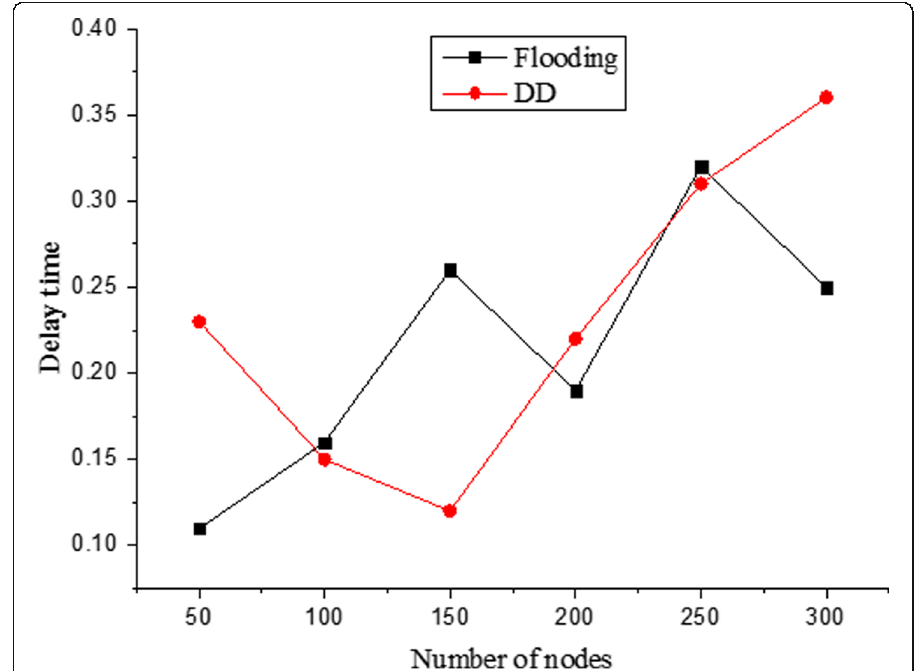
Fig. 3 Time-varying graph of the network size